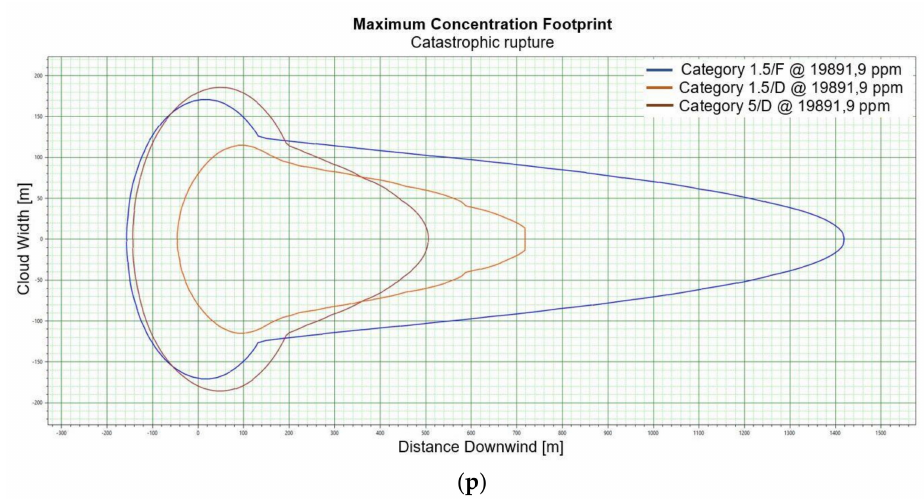
Figure 2. ( a ). Concentration for catastrophic rupture for LFL-fraction 1 m ASL LNG light, winter. ( b ). Concentration for catastrophic rupture for LFL-fraction 1 m ASL LNG light, summer. ( c ). Con- centration for catastrophic rupture for LFL-fraction 1 m ASL LNG heavy, winter. ( d ). Concentration for catastrophic rupture for LFL-fraction 1 m ASL LNG heavy, summer. ( e ). Concentration for catastrophic rupture for LFL-fraction 2 m ASL, LNG light, winter. ( f ). Concentration for catastrophic rupture for LFL-fraction 2 m ASL, LNG light, summer. ( g ). Concentration for catastrophic rupture for LFL-fraction 2 m ASL, LNG Heavy, winter. ( h ). Concentration for catastrophic rupture for LFL- fraction 2 m ASL, LNG Heavy, summer. ( i ). Concentration for catastrophic rupture for LFL-fraction 5 m ASL, LNG Light, winter. ( j ). Concentration for catastrophic rupture for LFL-fraction 5 m ASL, LNG Light, summer. ( k ). Concentration for catastrophic rupture for LFL-fraction 5 m ASL, LNG heavy, winter. ( l ). Concentration for catastrophic rupture for LFL-fraction 5 m ASL, LNG heavy, summer. ( m ). Concentration for catastrophic rupture for LFL-fraction 0 m ASL, LNG light, winter. ( n ). Concentration for catastrophic rupture for LFL-fraction 0 m ASL LNG, light, summer. ( o ). Con- centration for catastrophic rupture for LFL-fraction 0 m ASL LNG heavy, winter. ( p ). Concentration for catastrophic rupture for LFL-fraction 0 m ASL, LNG heavy,